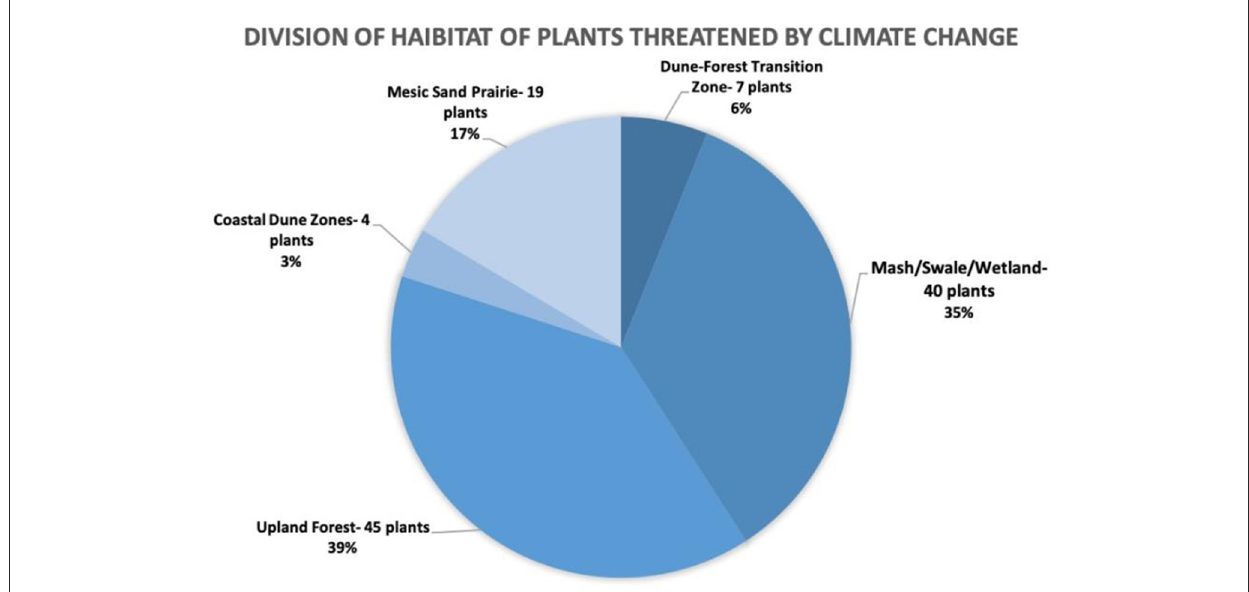
FIGURE4 Division by habitat threatened by climate change ( N = 15).